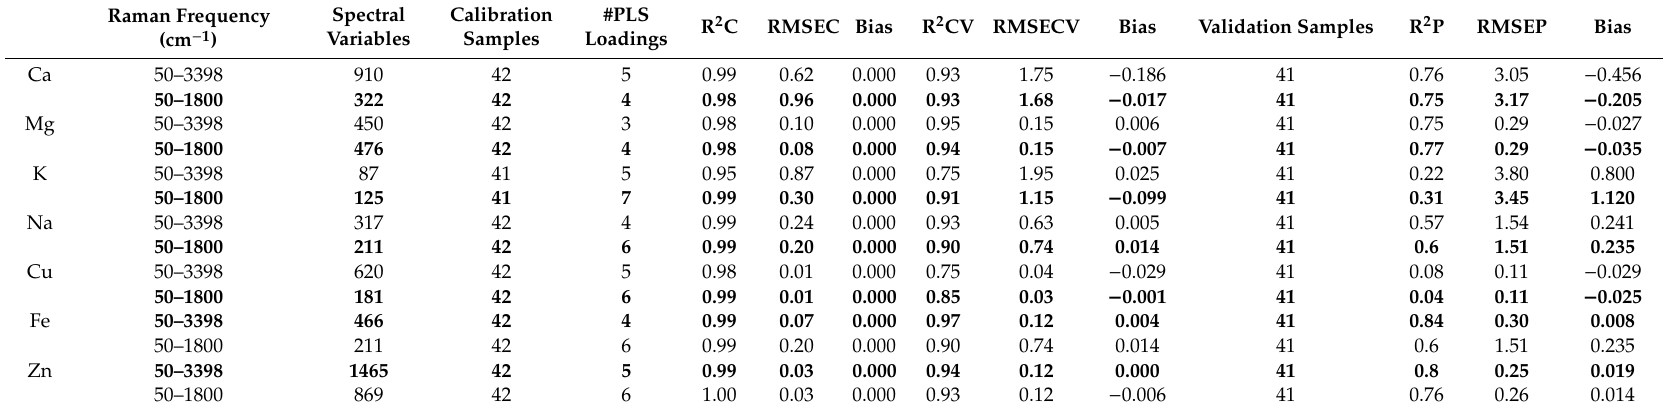
Table 4. Summary of venetian blinds cross-validation PLSR performances (Raman frequency: 50–3398 cm − 1 and 50–1800 cm − 1 ) based on AsLs baseline corrected Raman spectra for mineral elements prediction (most accurate models in